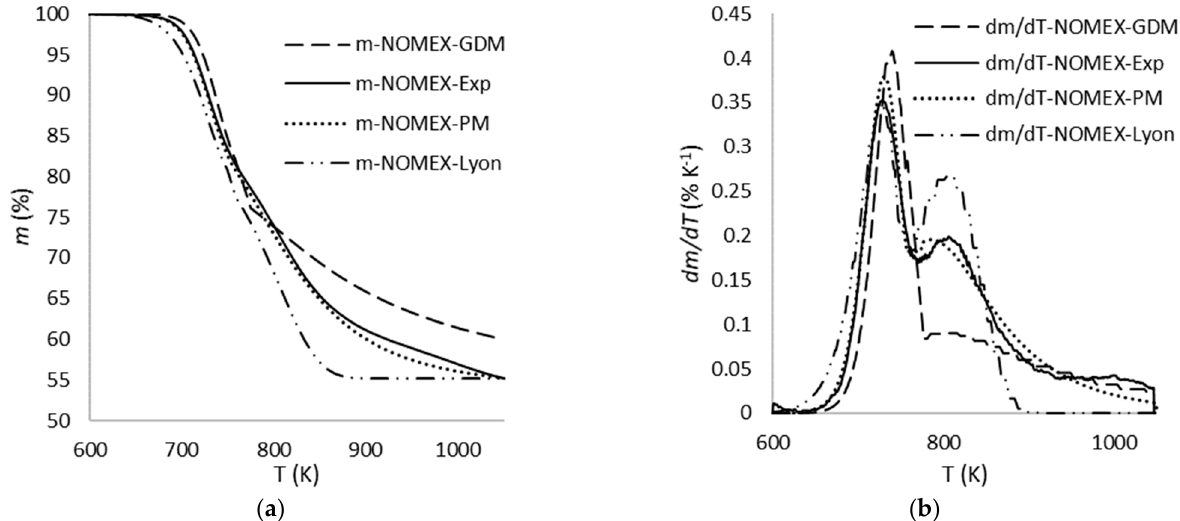
Figure 14. A comparison of experimental and calculated ( a ) mass and ( b ) dm / dT results for NOMEX.